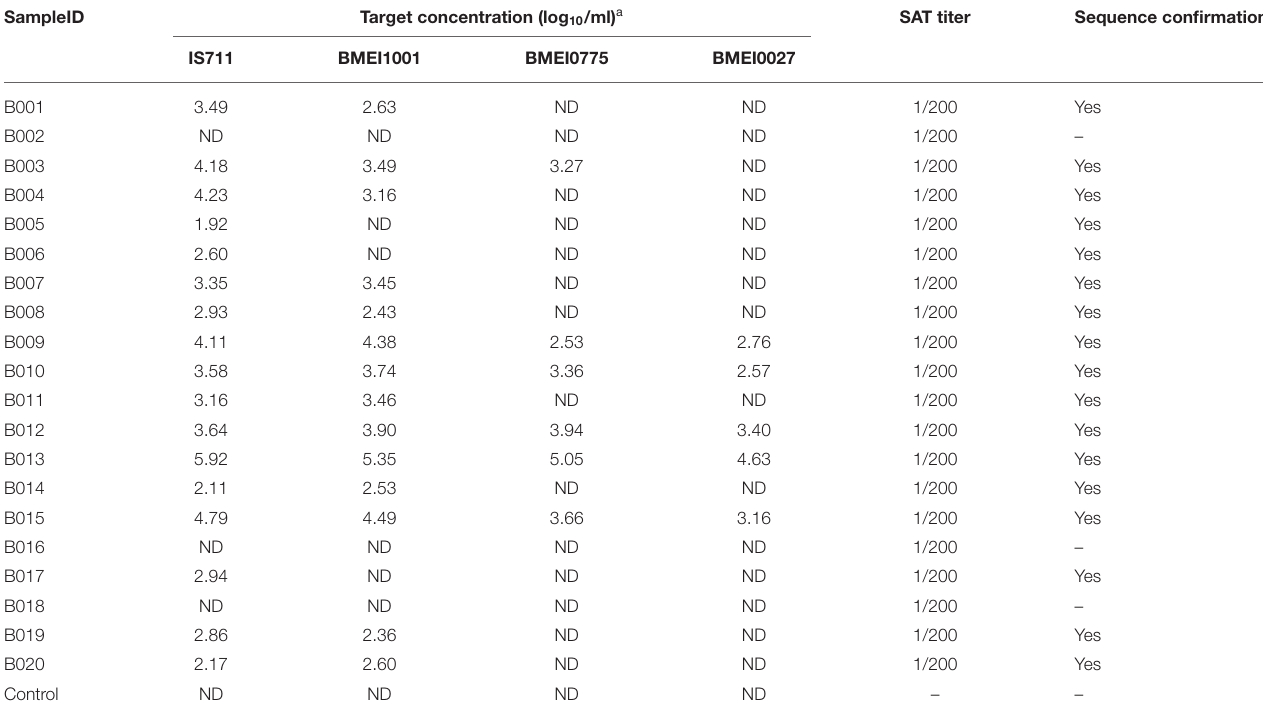
TABLE 4 | Detection results of 20 clinical blood samples from brucellosis patients.